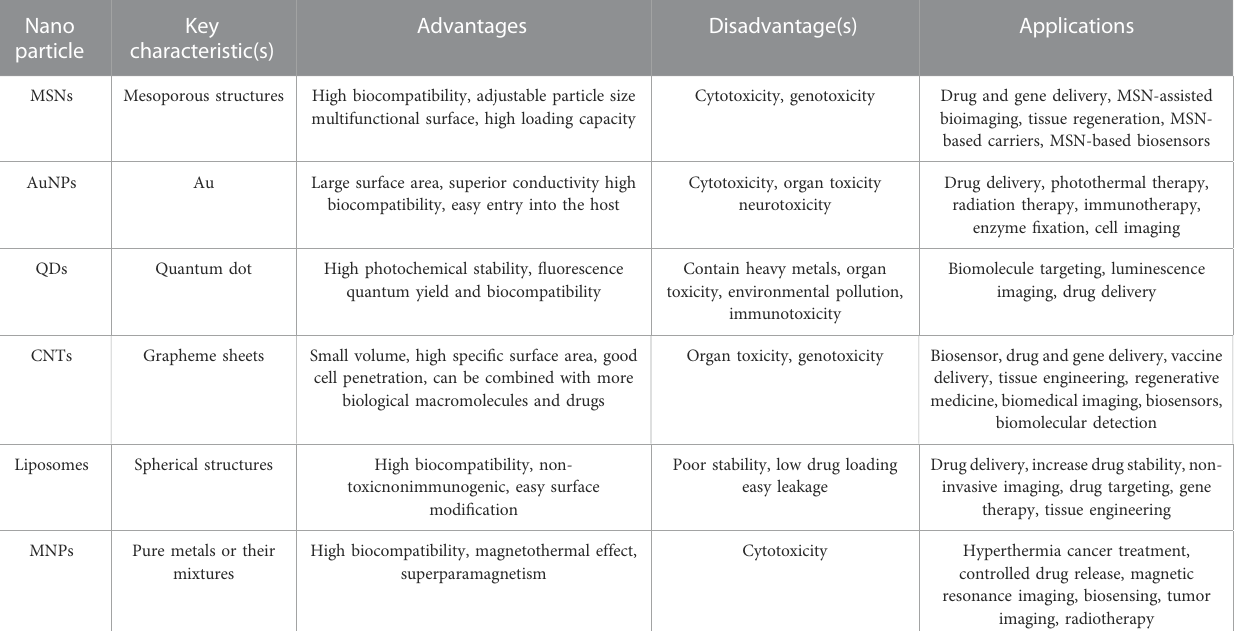
TABLE 1 Nanoparticle